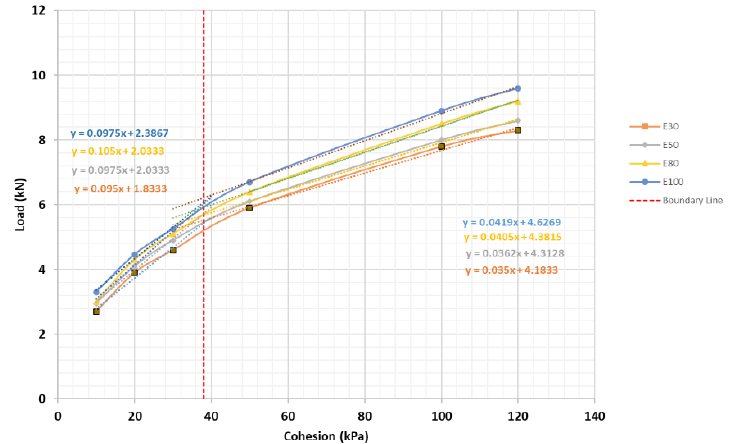
Figure 9. Relationship between cohesive force and ultimate bearing capacity for CHSB 1